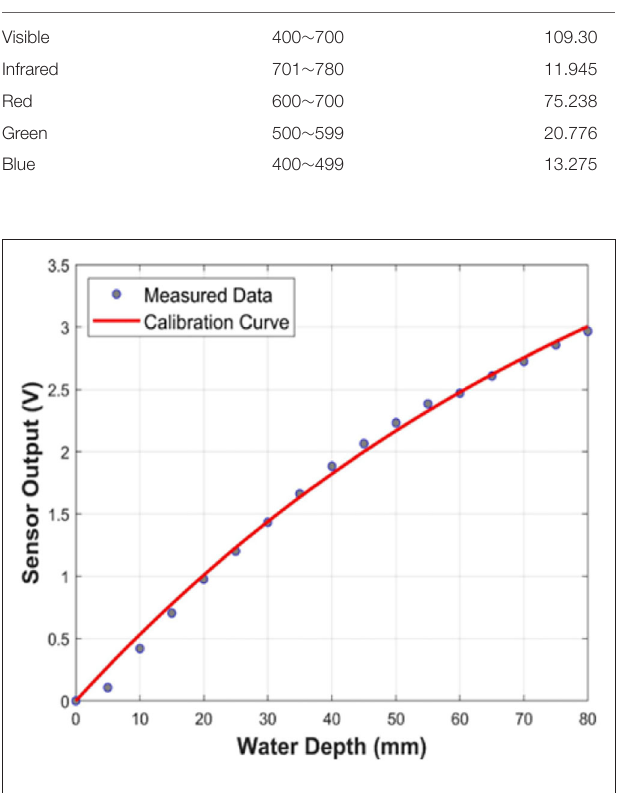
FIGURE 1 | Calibration curve of sensor voltage (V) in response to water depth (mm). R 2 =